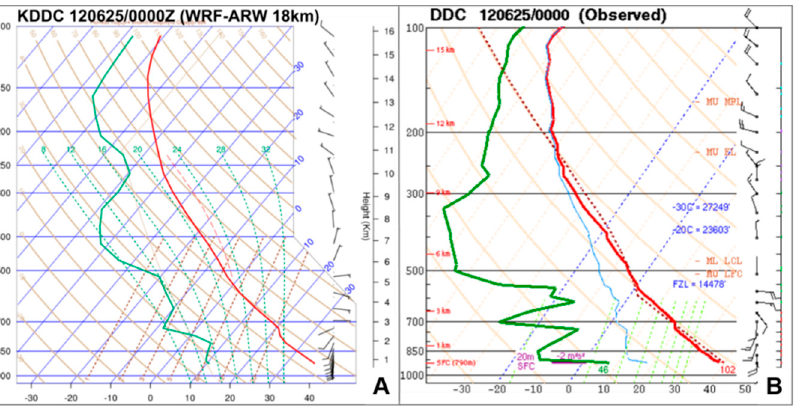
Figure 13. Comparison of the 00Z 25 June 2012 ( A ) WRF-ARW KDDC 18 km simulated upper air analysis and ( B ) observed KDDC upper air sounding.